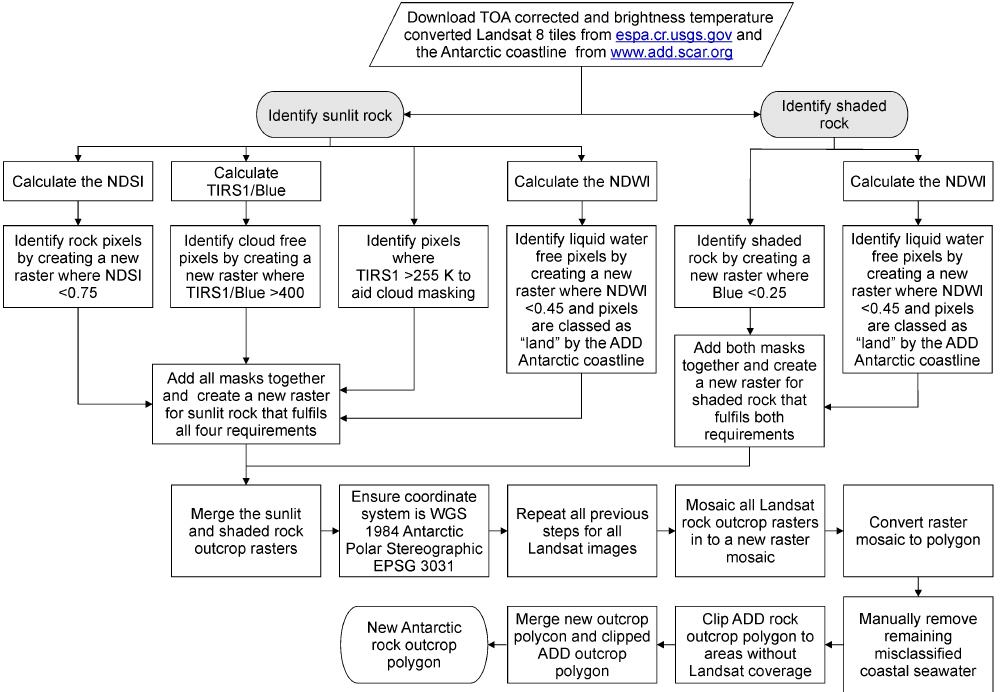
Figure 5. Flowchart for the automated identification of rock outcrops in Antarctica. Threshold values are given without the 16bit scaling used in the corrected Landsat 8 raster